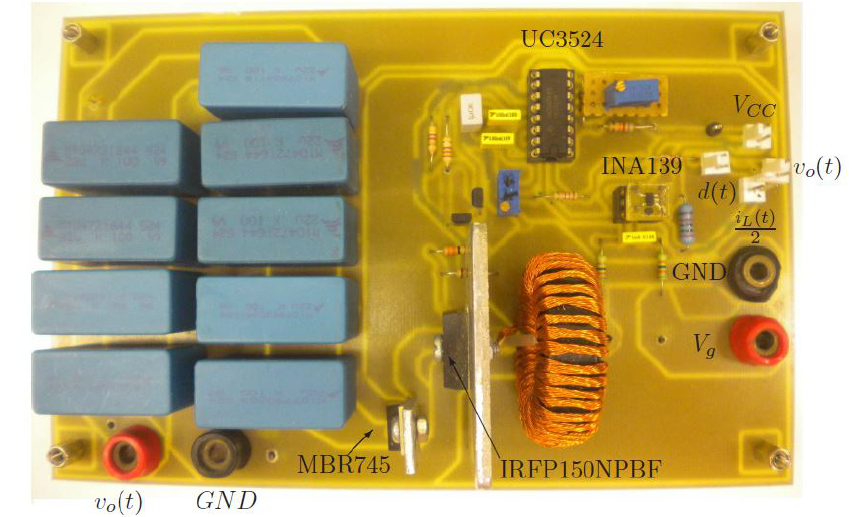
Figure 11. Boost converter prototype.